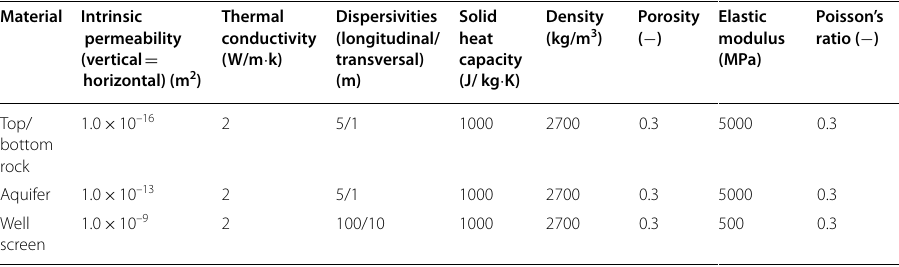
Table 2 Main parameters for preliminary calculations Material Intrinsic